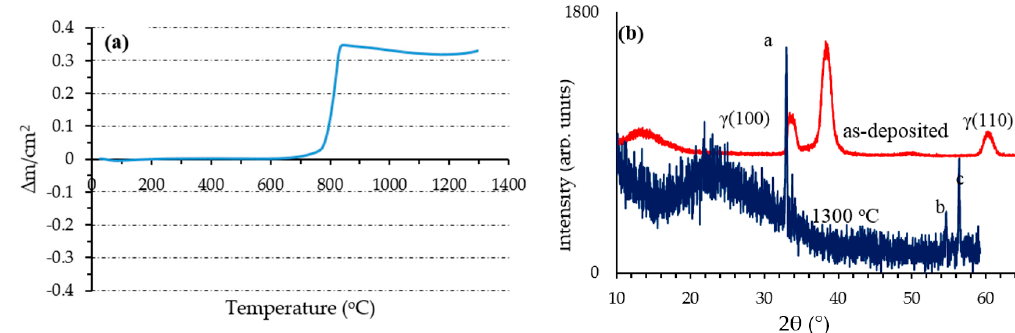
Figure 12. ( a ) TGA response of Ta–Si–N film deposited with 13% N 2 showing weight change per unit area ( Δ m/cm 2 ) and ( b ) XRD of the 13% N 2 film before and after